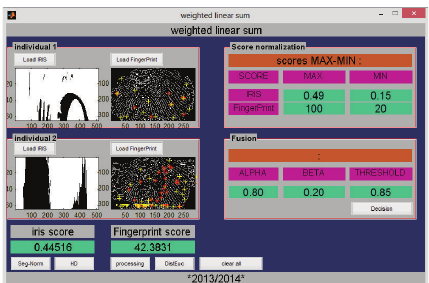
Figure 12: GUI showing the matching using the fusion by the weighted sum rule.